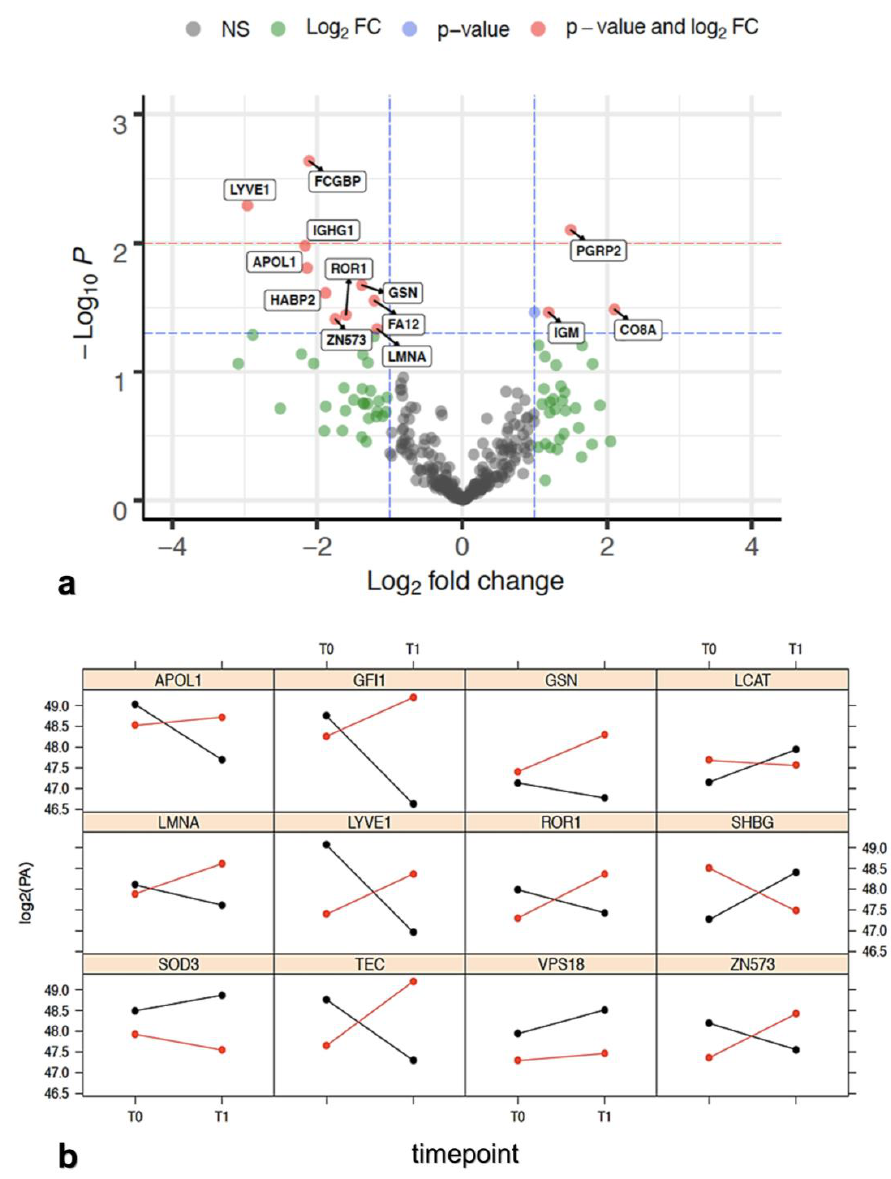
Figure 2. ( a ) Volcano plot showing -log 10 ( p -value) versus log 2 (FC R /FC NR ). Horizontal lines indicate 0.05 (blue) and 0.01 (red) p -values. Proteins statistically significant ( p < 0.05) and with a FC > 1 were reported alongside with their names. Protein in red dot fits the FC and statistical significance criteria, blue dot fits only the statistical criteria, the green dot fits only the FC criteria, and the grey dot does not fit either criteria. Proteins over the blue dashed line showing p < 0.05 are reported in Table 1. Data for each protein were taken from the protein identification table of the MS analysis elaboration. (Supplementary Materials doi.org/10.15490/fairdomhub.1.datafile.4074.1); ( b ) log 2 protein abundance expression profile between T0 and T1 relative to the 10 proteins reported in Table 2. SOD3 and VPS18, taken from Table S5a, are added as an example of non-intersecting proteins. The red color is related to NR patients, while the black color is related to PR. When the red and black lines intersect, it is intended that the contribution of the time in response status is relevant and, consequently, the interaction between response and treatment as well. Data are elaborated from the file named “Report progenesis _all rows_all data for biostatistics.doi.org/10.15490/fairdomhub.1.